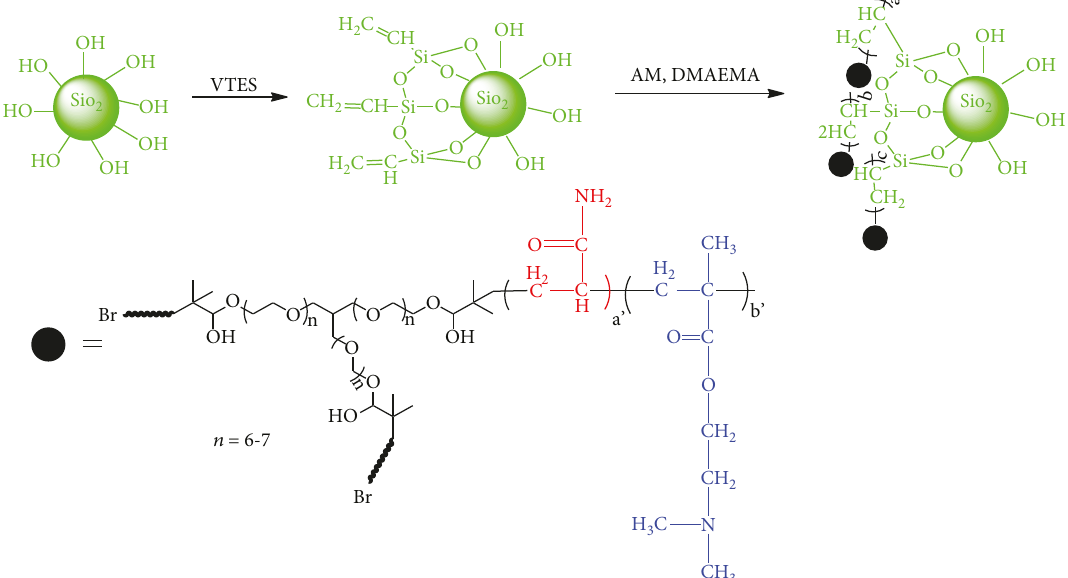
Scheme 1: Synthesis of NSFM and